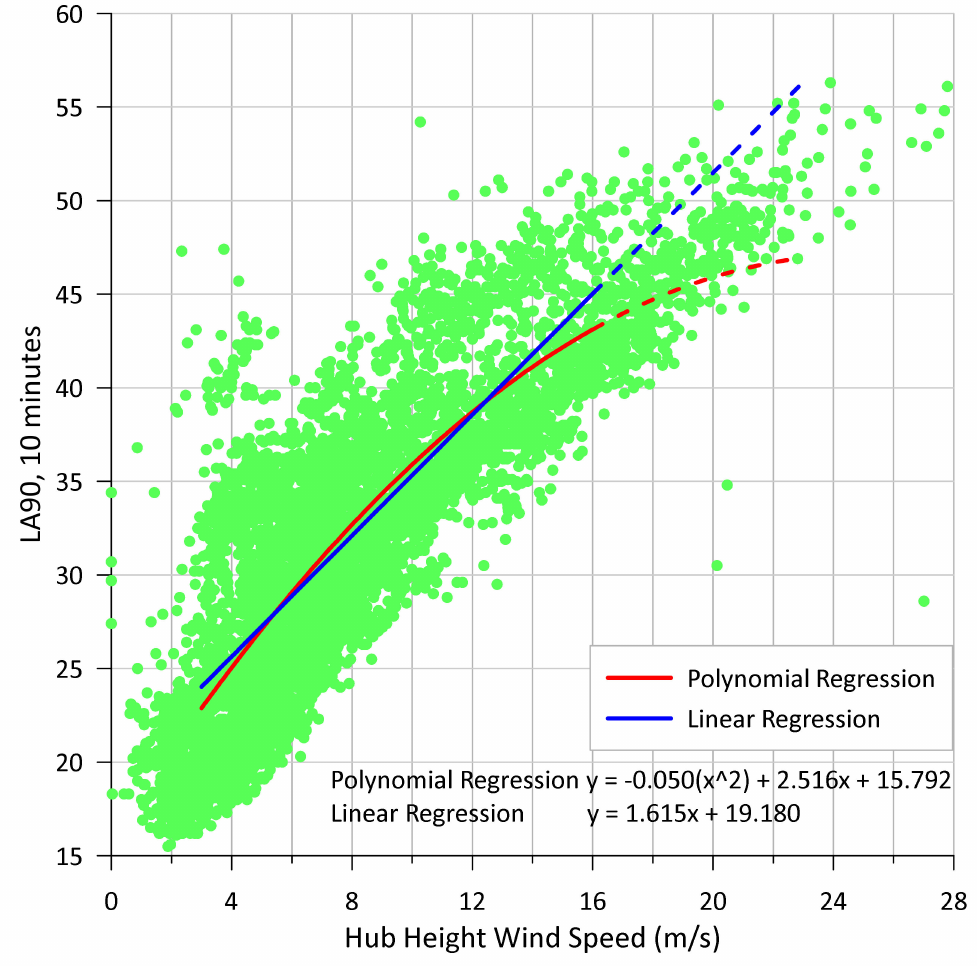
Figure 3. Regression Analysis of data for House 88 in Cape Bridgewater study [50] with permission from The Acoustic Group,